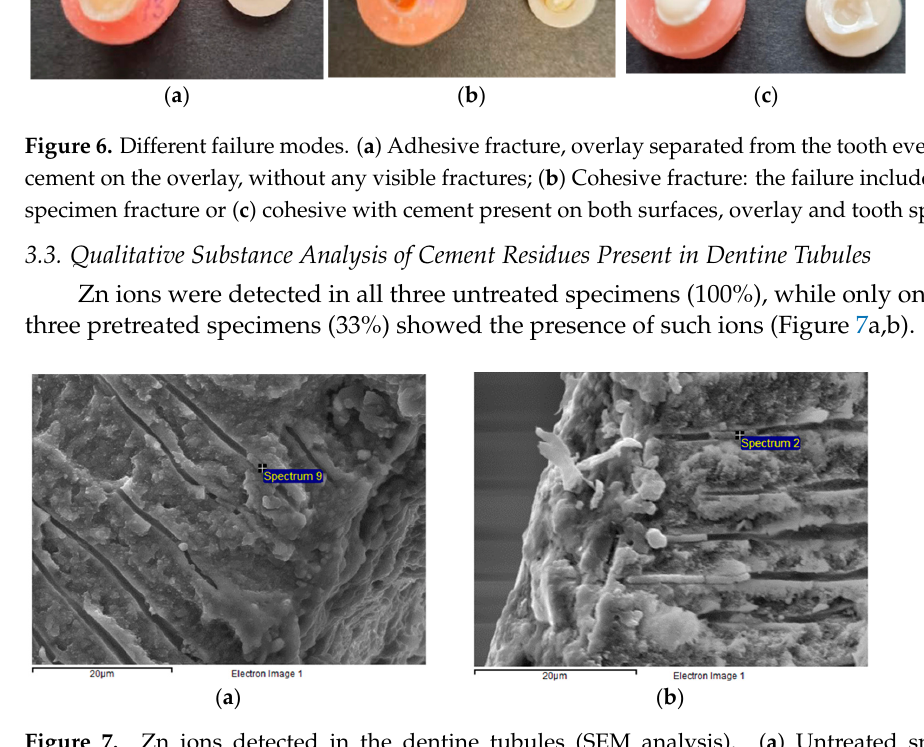
Figure 7 . Zn ions detected in the dentine tubules (SEM analysis). ( a ) Untreated specimen; ( b ) Pre ‐ treated specimen. ( b ) Pretreated